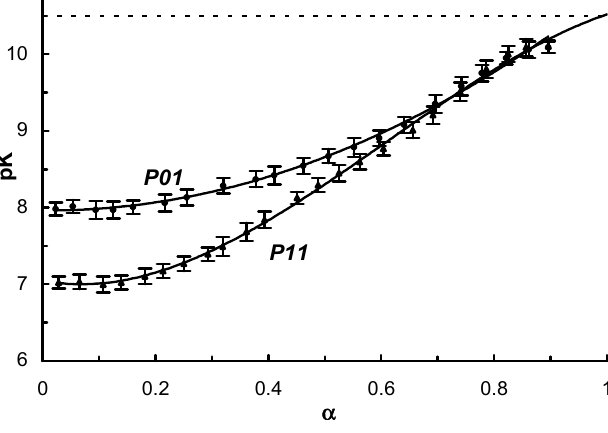
Figure 4. Dependence of pK vs. α for P01 and P11 polymers.